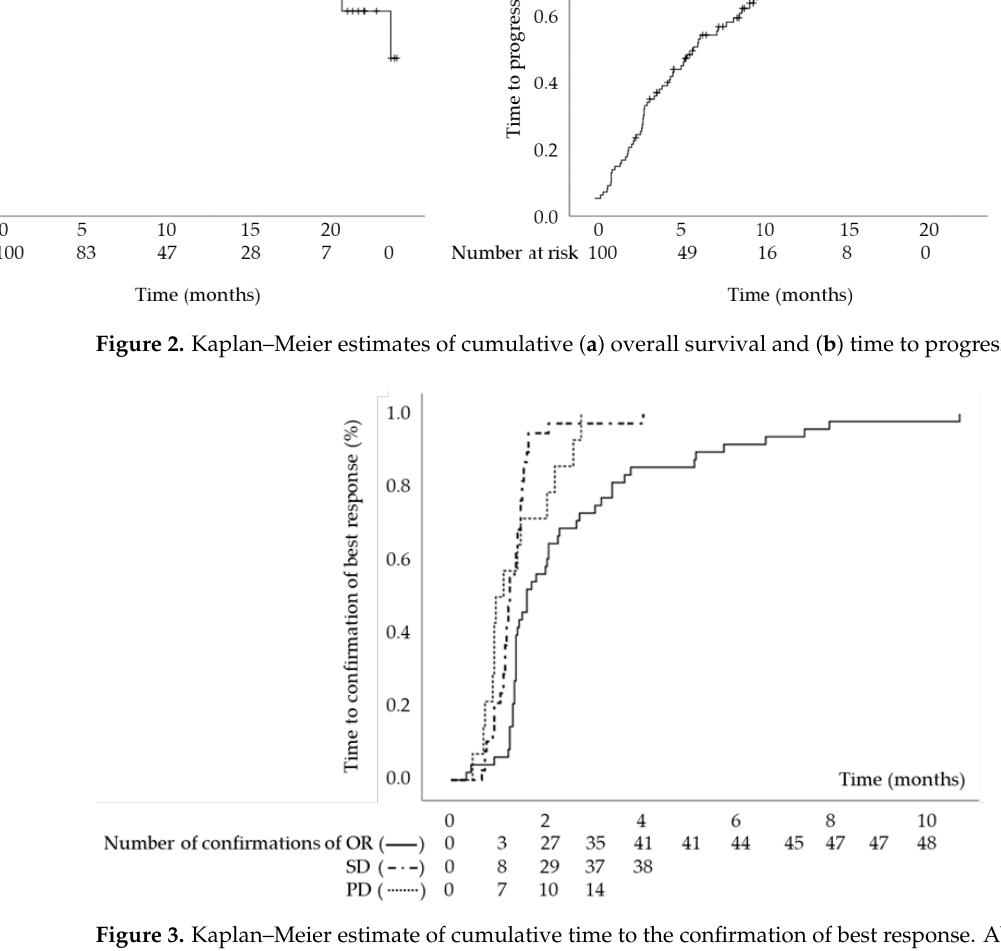
Figure 3. Kaplan – Meier estimate of cumulative time to the confirmation of best response. Abbrevi- ations: OR, objective response; PD, progressive disease; SD, stable disease.